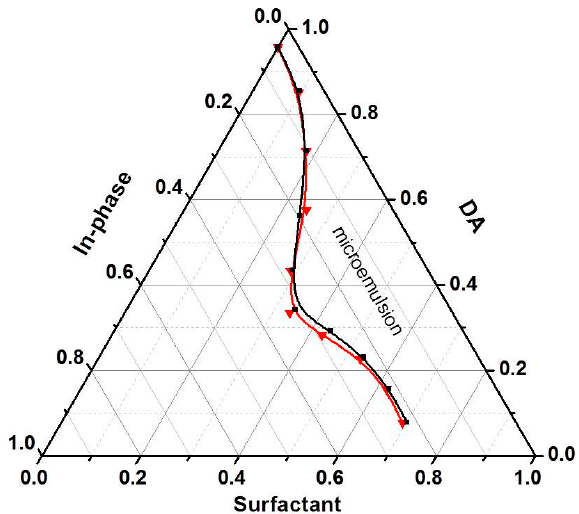
Figure 2. Partial phase diagram for systems of decanol/Triton X-100/water (black line) and decanol/Triton X-100/KDP aq (red line).